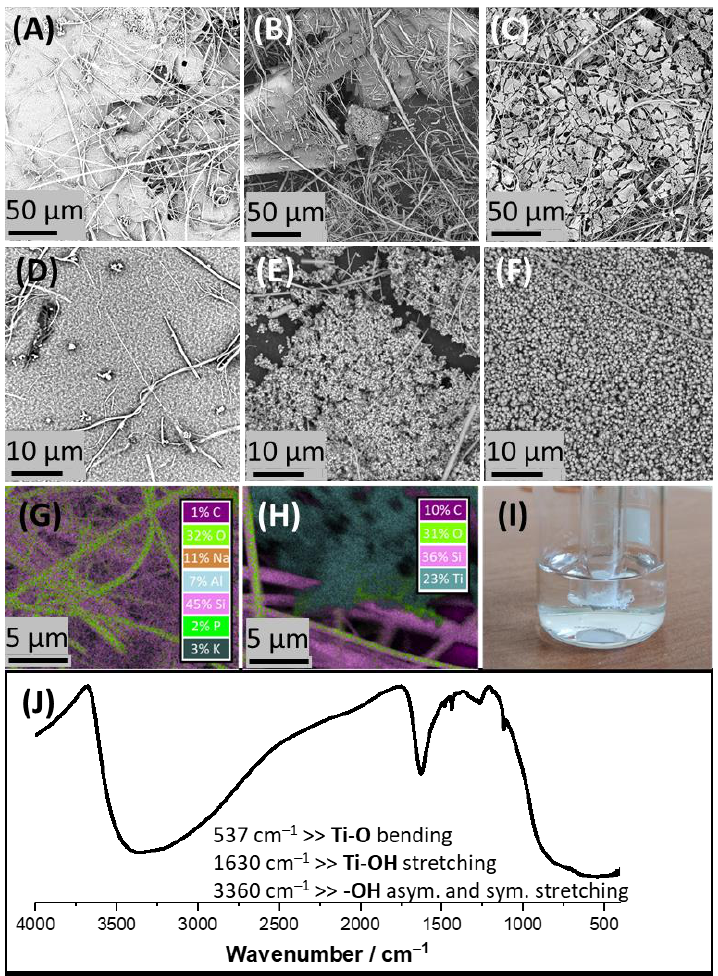
Figure 3. ( A – F ) The SEM micrographs recorded for the TiO 2 collected from the LLI with